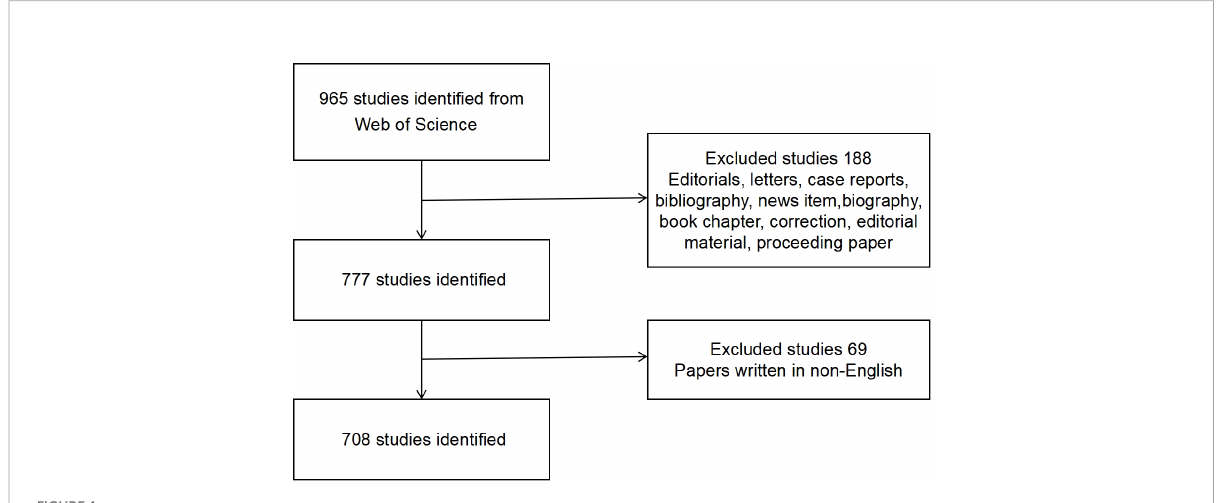
FIGURE 1 Flow diagram of CM researches inclusion